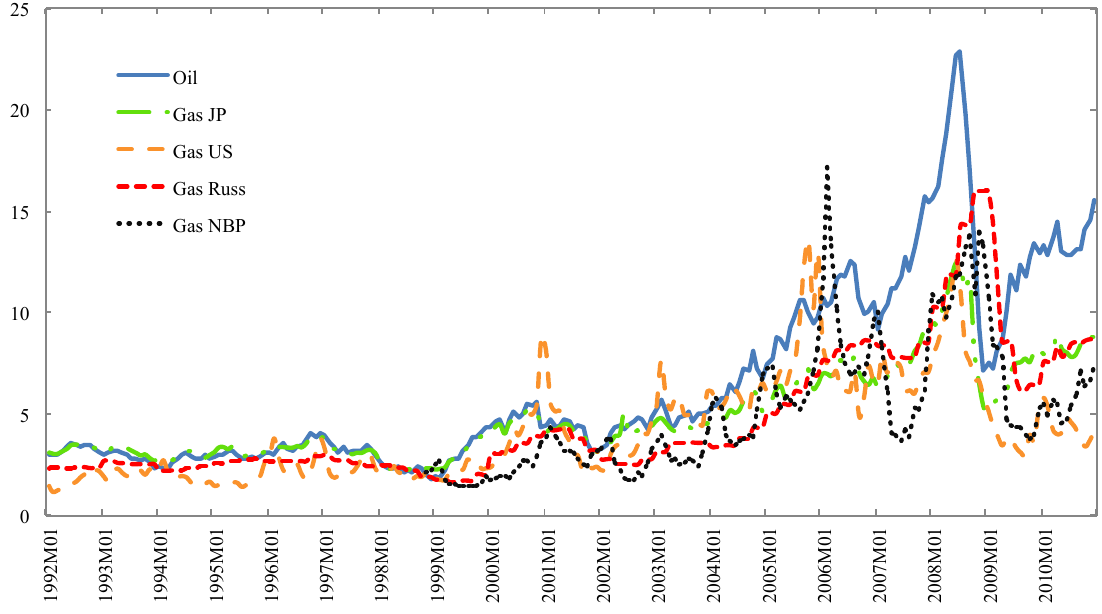
Figure 1. The prices of crude oil, US Henry Hub, Russian and NBP natural gas and Japanese liquefied natural gas (LNG) in $/MMBtu from 1992 to